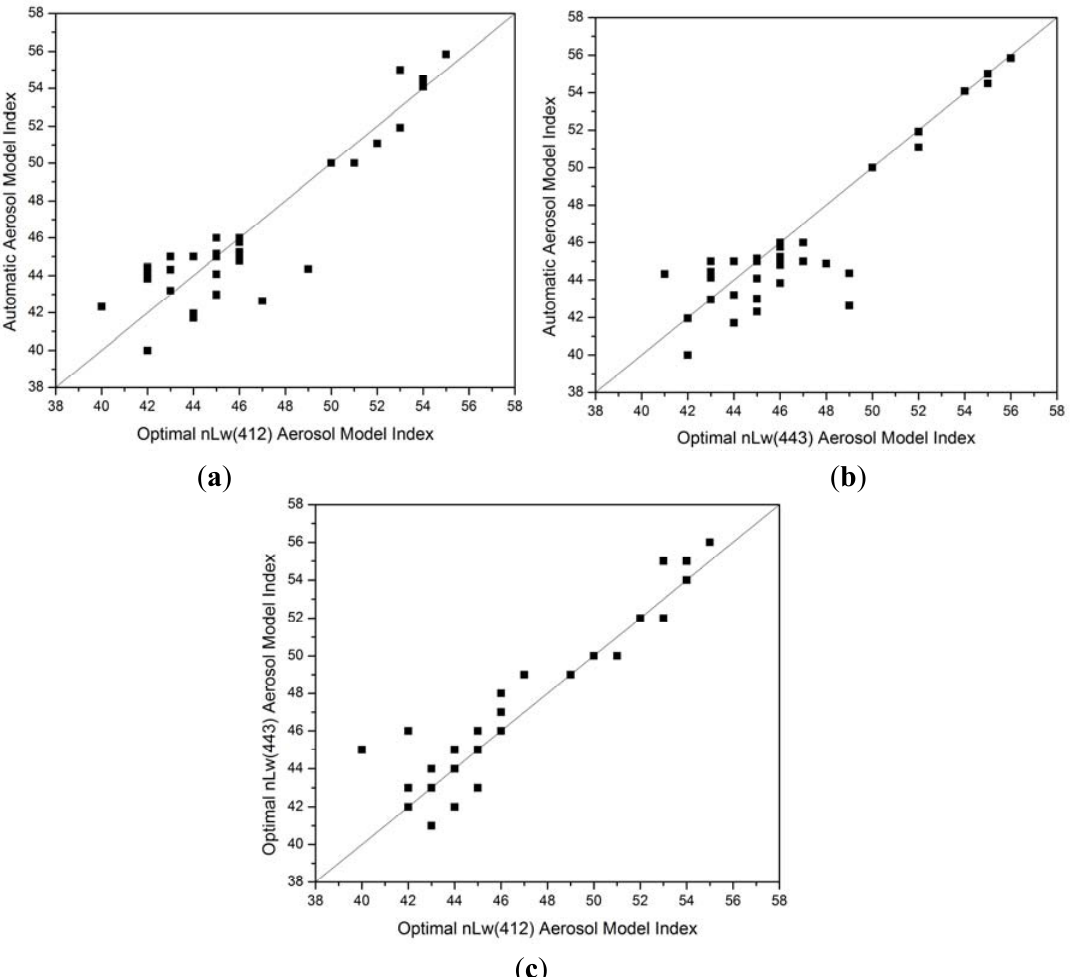
Figure 6. Comparison of aerosol model selection, Martha’s Vineyard, 2010. ( a ) Automatic model selection (modmin) vs. optimal model selection (modmin) for but for L (443), ( c ) Optimal aerosol model selection (modmin) for n w aerosol selection (modmin) for L (412). Line represents 1:1 relationship. Optimal models n w selected from the set of 10 possible aerosol models (representing size fraction) after the relative humidity has already been determined from